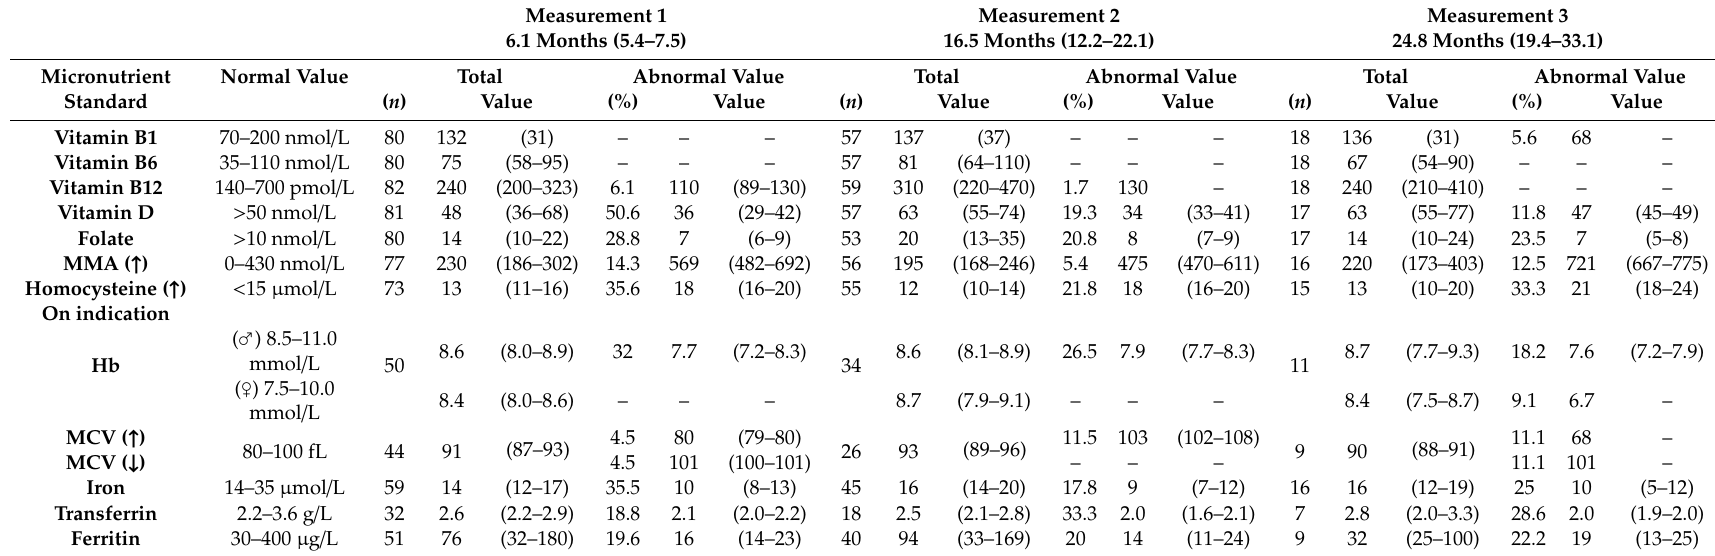
Table 3. Hematological and nutritional profile in postoperative